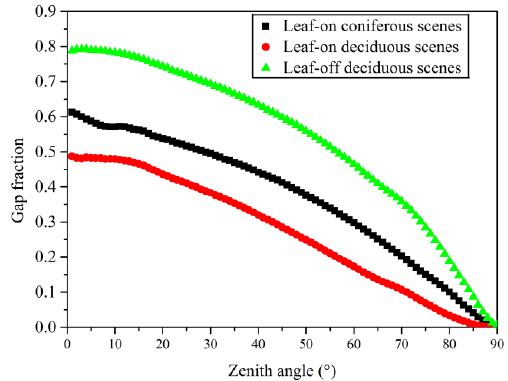
p  and ( ) p  of leaf-on and leaf-off forest scenes, which were derived by Figure 3. The mean ( ) e w Figure 3. The mean p e ( θ ) and p w ( θ ) of leaf-on and leaf-off forest scenes, which were derived by p  and ( ) p  of all scenes at zenith angles in the 0–90° range with interval of 1°. averaging the ( ) e w averaging the p e ( θ ) and p w ( θ ) of all scenes at zenith angles in the 0–90 ◦ range with interval of 1 ◦ . Table 2. Mean PAI e of leaf-on coniferous and deciduous scenes and mean WAI e of leaf-off deciduous scenes derived from seven inversion models using Equations (3)–(7), (9) and (10) by assuming G e ( θ ) and G w ( θ ) to be equal to 0.5 ( γ e , Ω e ( θ ) , Ω w ( θ ) , Ω e ( θ (cid:48) ) , Ω w ( θ (cid:48) ) , Ω e _ i , and Ω w _ i are assumed to be equal to 1).